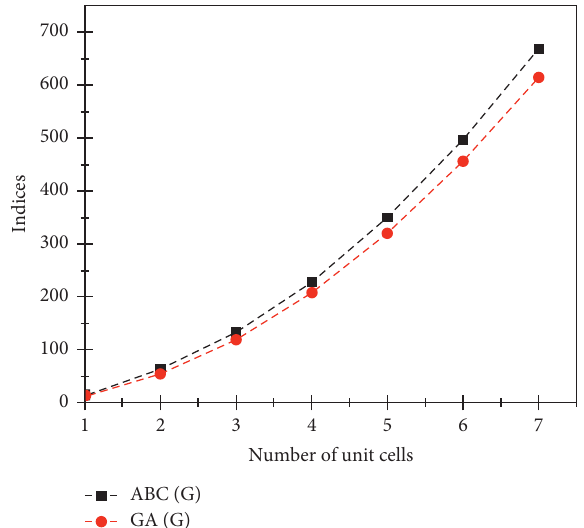
Figure 4: Comparison of ABC ( G ) and GA ( G ) indices for InP [ s, t ] .